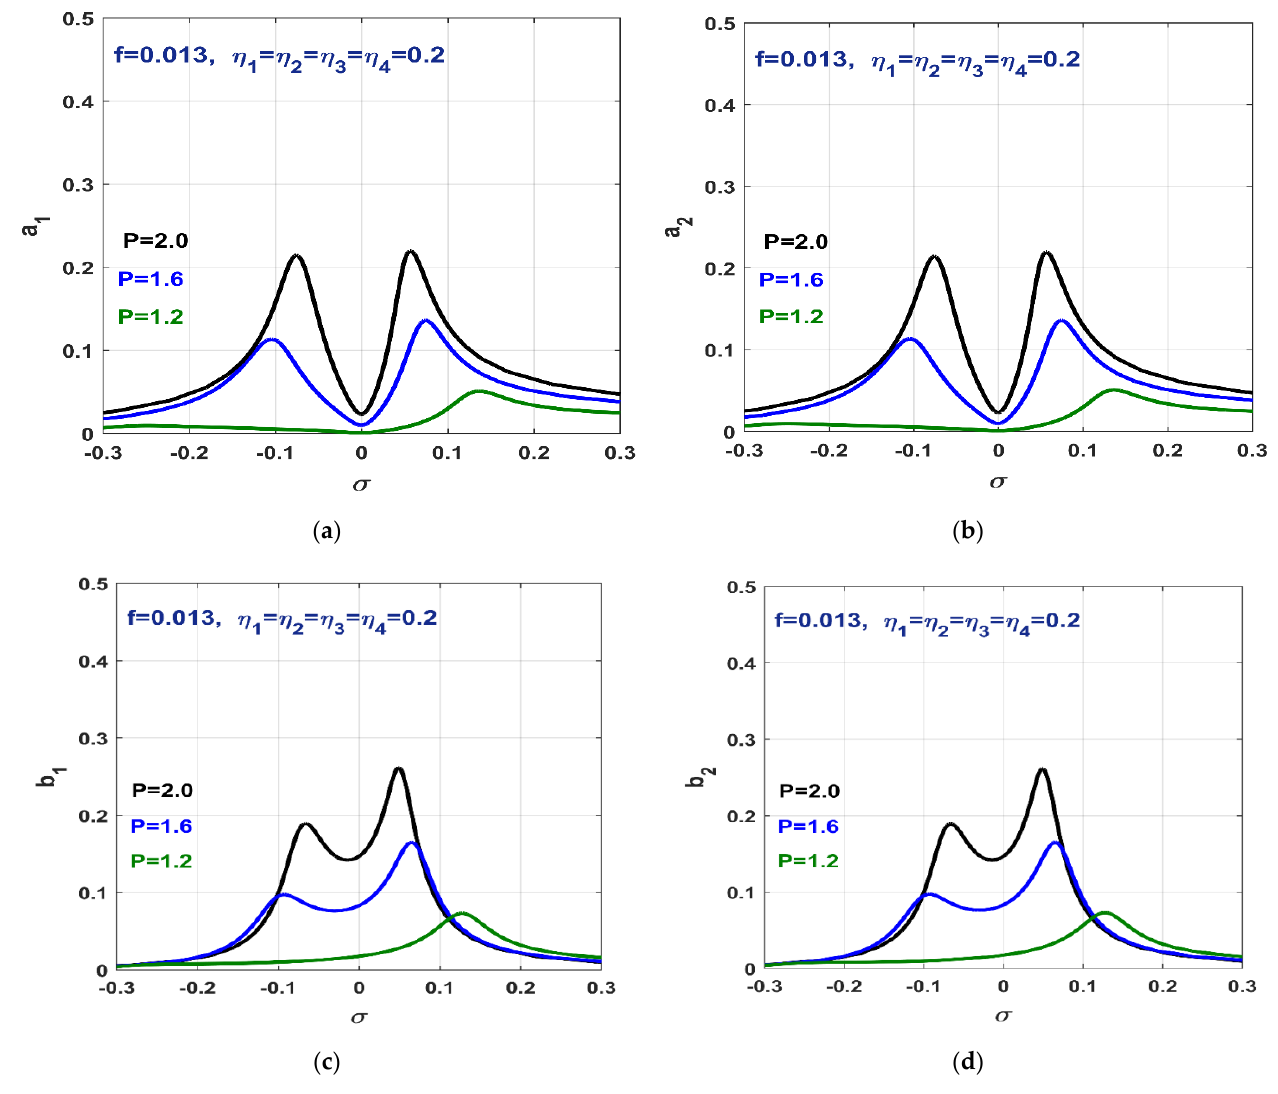
Figure 7. Vibration amplitudes of the twelve-poles rotor in the case of the PD + IRC + PPF -control algorithm at f = 0.013, η 1 = η 2 = η 3 = η 4 = 0.2 when p = 1.2, 1.6, and 2.0: ( a , b ) vibration amplitudes ( a 1 , a 2 ) of the rotor, and ( c , d ) vibration amplitudes ( b 1 , b 2 ) of the PPF